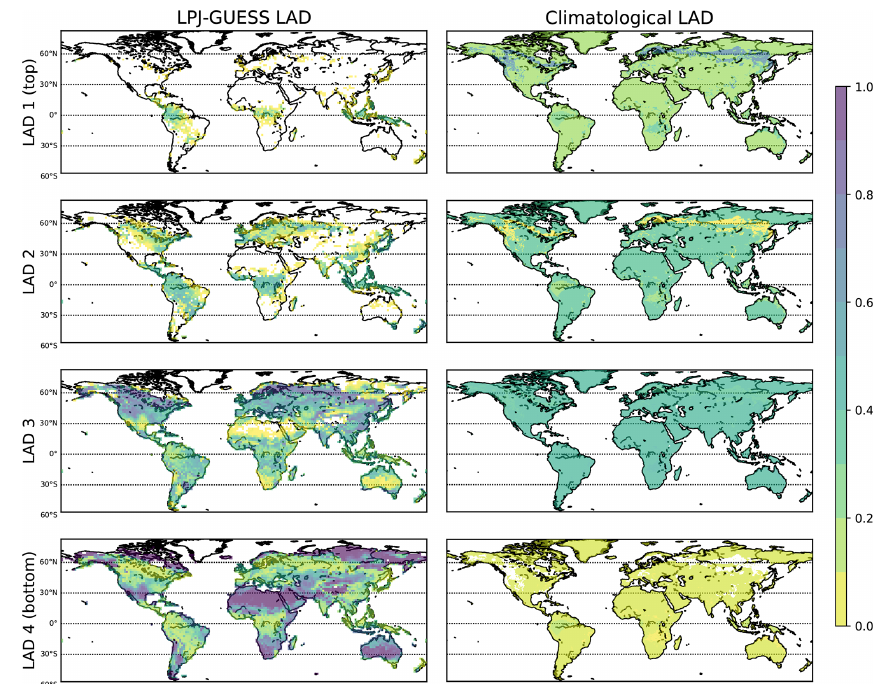
Figure 6. LAD fraction at four canopy layers from LPJ-GUESS (left panels) and the DDIM model (right panels). While the climatological LAD is oversimplified and homogeneous, LPJ-GUESS provides a higher-resolved LAD distribution at the four canopy layers.